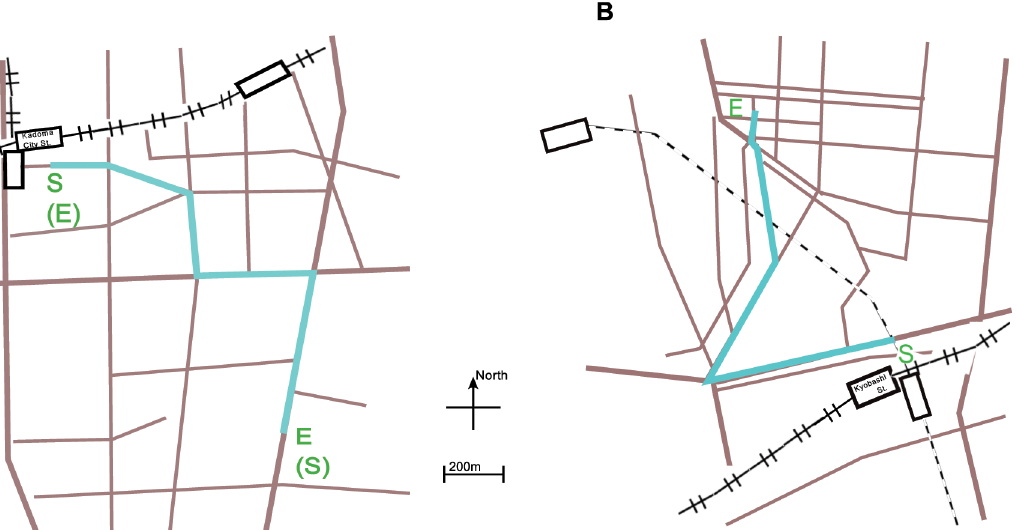
Fig 1. Maps of routes displayed in movies. ‘ S ’ on the maps denotes the starting point, and ‘ E ’ the endpoint for each route. Cyan line represents the routes of movies. (A) A route in movie-1 and -2, with ‘ S ’ and ‘ E ’ for movie-1 and ‘ S ’ and ‘ E ’ with parentheses for movie-2. (B) A route in